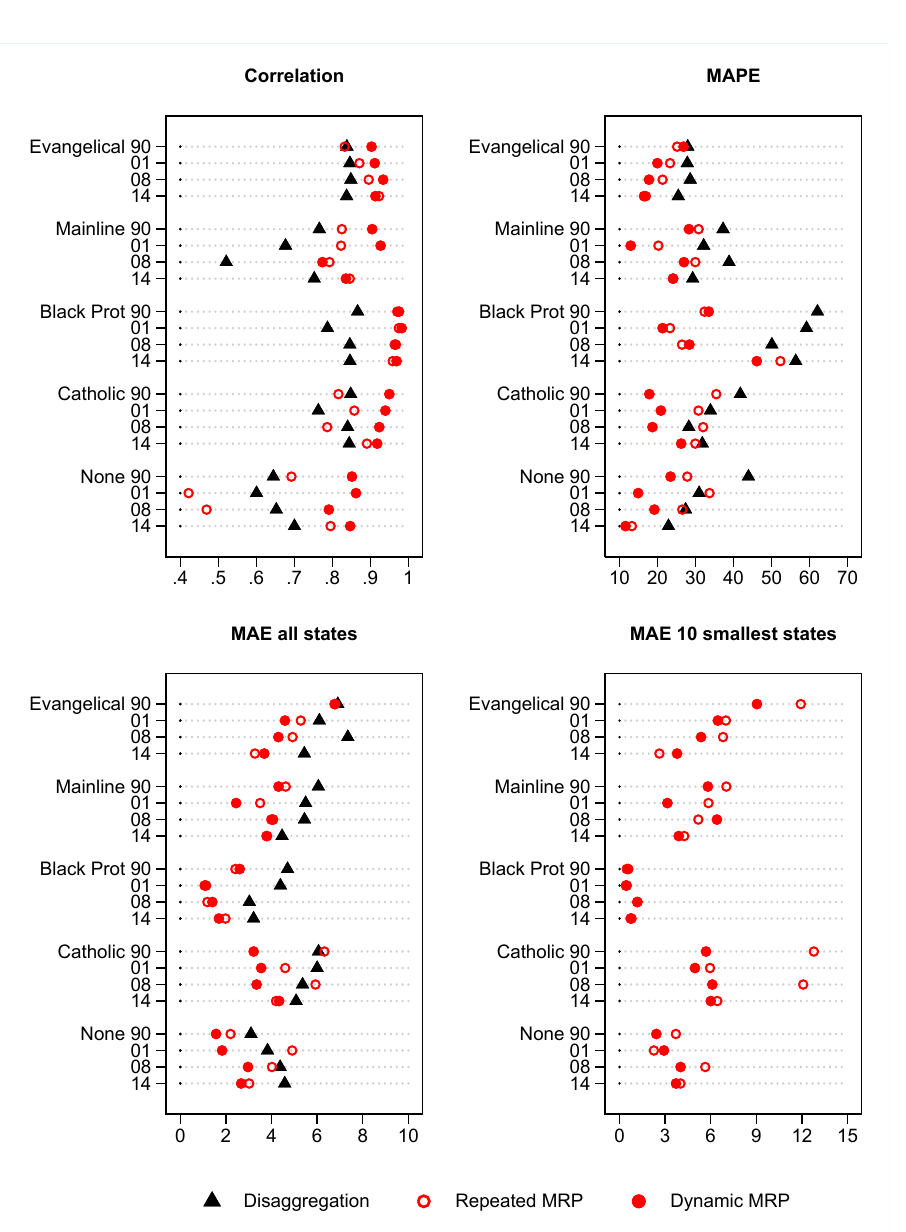
Figure 1: Comparisons of GSS-based estimates with external benchmarks: Religious affiliations. Notes: The reported statistics are based on all available estimates for a given year. Disaggregation provides estimates for 38 to 41 states per year. Repeated MRP and Dynamic MRP provide estimates for all 50 states and the District of Columbia. The bottom-right panel considers the 10 smallest states by population size other than Alaska, Hawaii, and the District of Columbia, which have been ignored to ensure consistent samples over